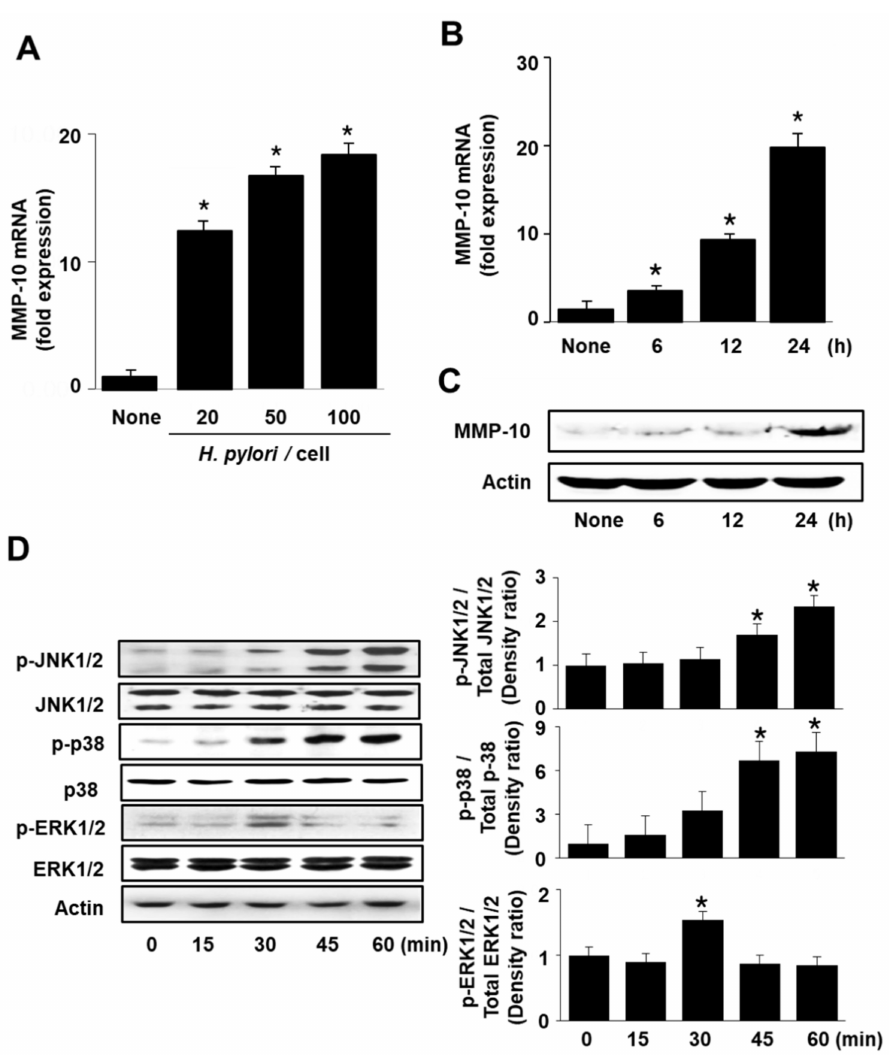
Figure 1. H. pylori induces the expression of MMP-10 and activation of MAPKs in AGS cells. ( A ) Cells were infected with H. pylori at the indicated ratios ( H. pylori /cells) for 24 h. ( B – D ) Cells were infected with H. pylori at a 1:50 ratio for the indicated time periods. ( A , B ) The expression of MMP-10 mRNA was analyzed by real-time PCR and normalized to β -actin mRNA. All data are shown as